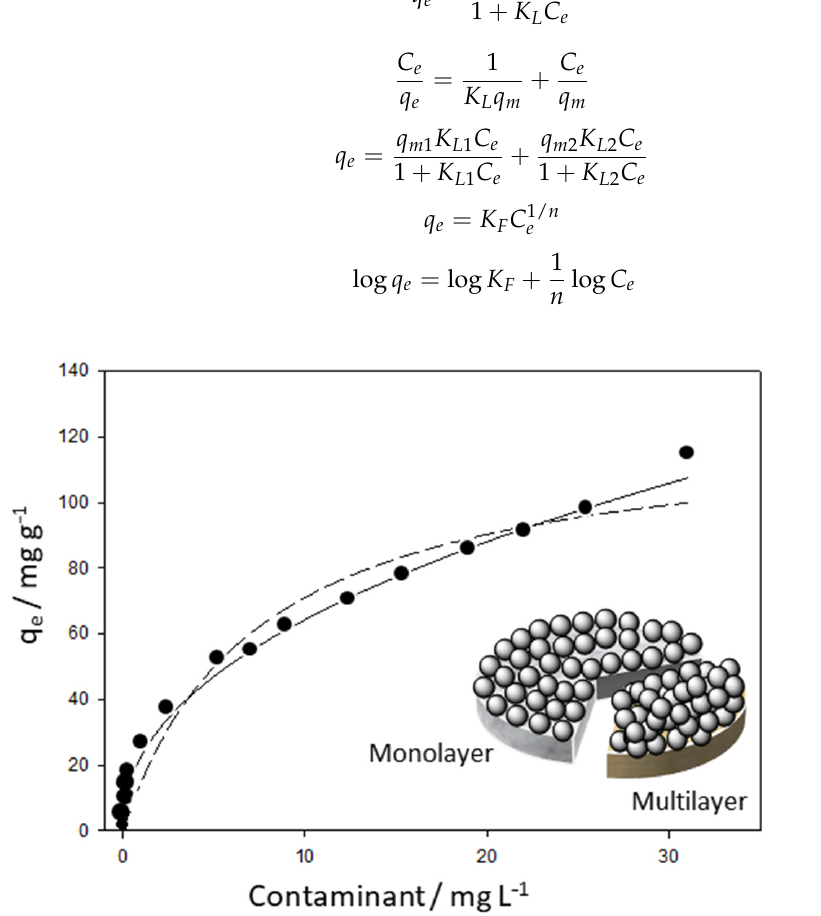
Figure 7. Schematic of an adsorption plot showing experimental data (symbols), with the —— Freundlich isotherm and − − − Langmuir isotherm fitting and the inset shows monolayer and multilayer adsorption processes.